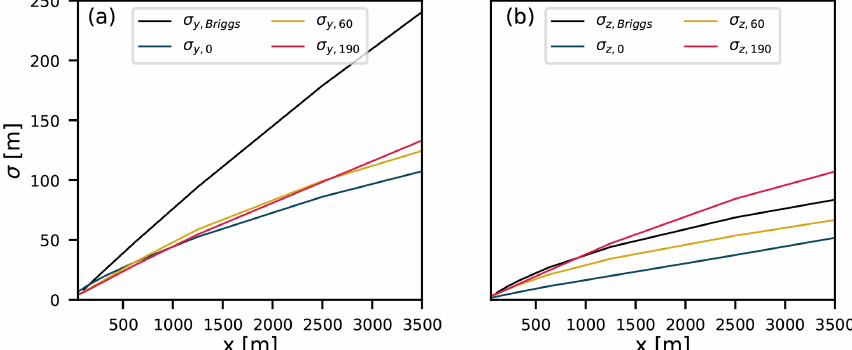
Figure 7. (a) Horizontal and (b) vertical plume width as a function of downwind distance from the source. Plume widths are shown for all three release heights as well as plume widths calculated using Briggs (Eq.